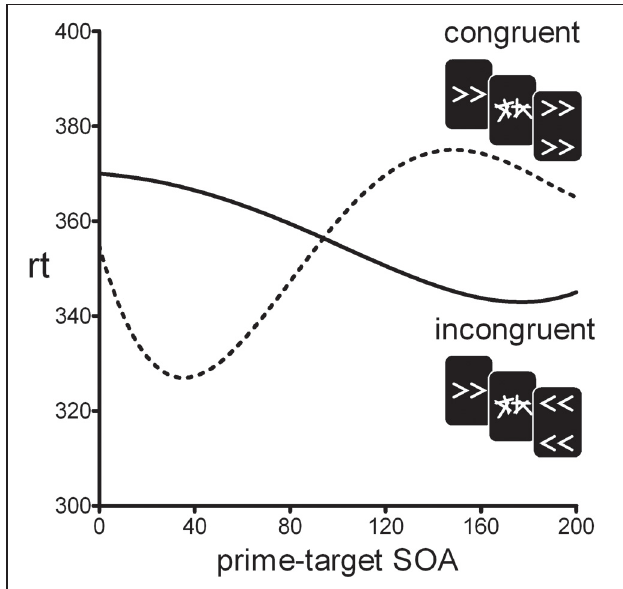
FIGURE 1 | Typical time-course of the positive congruency effect (PCE ≈ 0–100 SOA) and the negative congruency effect (NCE ≈ 100–250